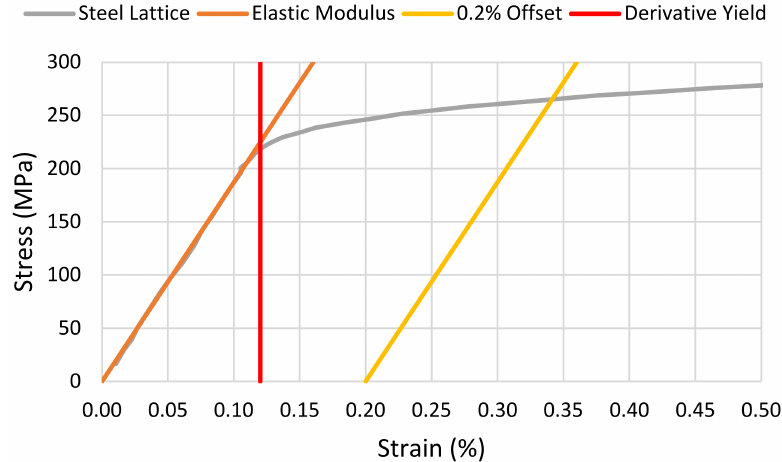
Figure 11. Comparison of the results from the offset yield and the derivative yield as applied to the experimentally measured stress–strain curve for a steel lattice subjected to tensile loading. The Strain axis to 0.5 enables the best illustration.